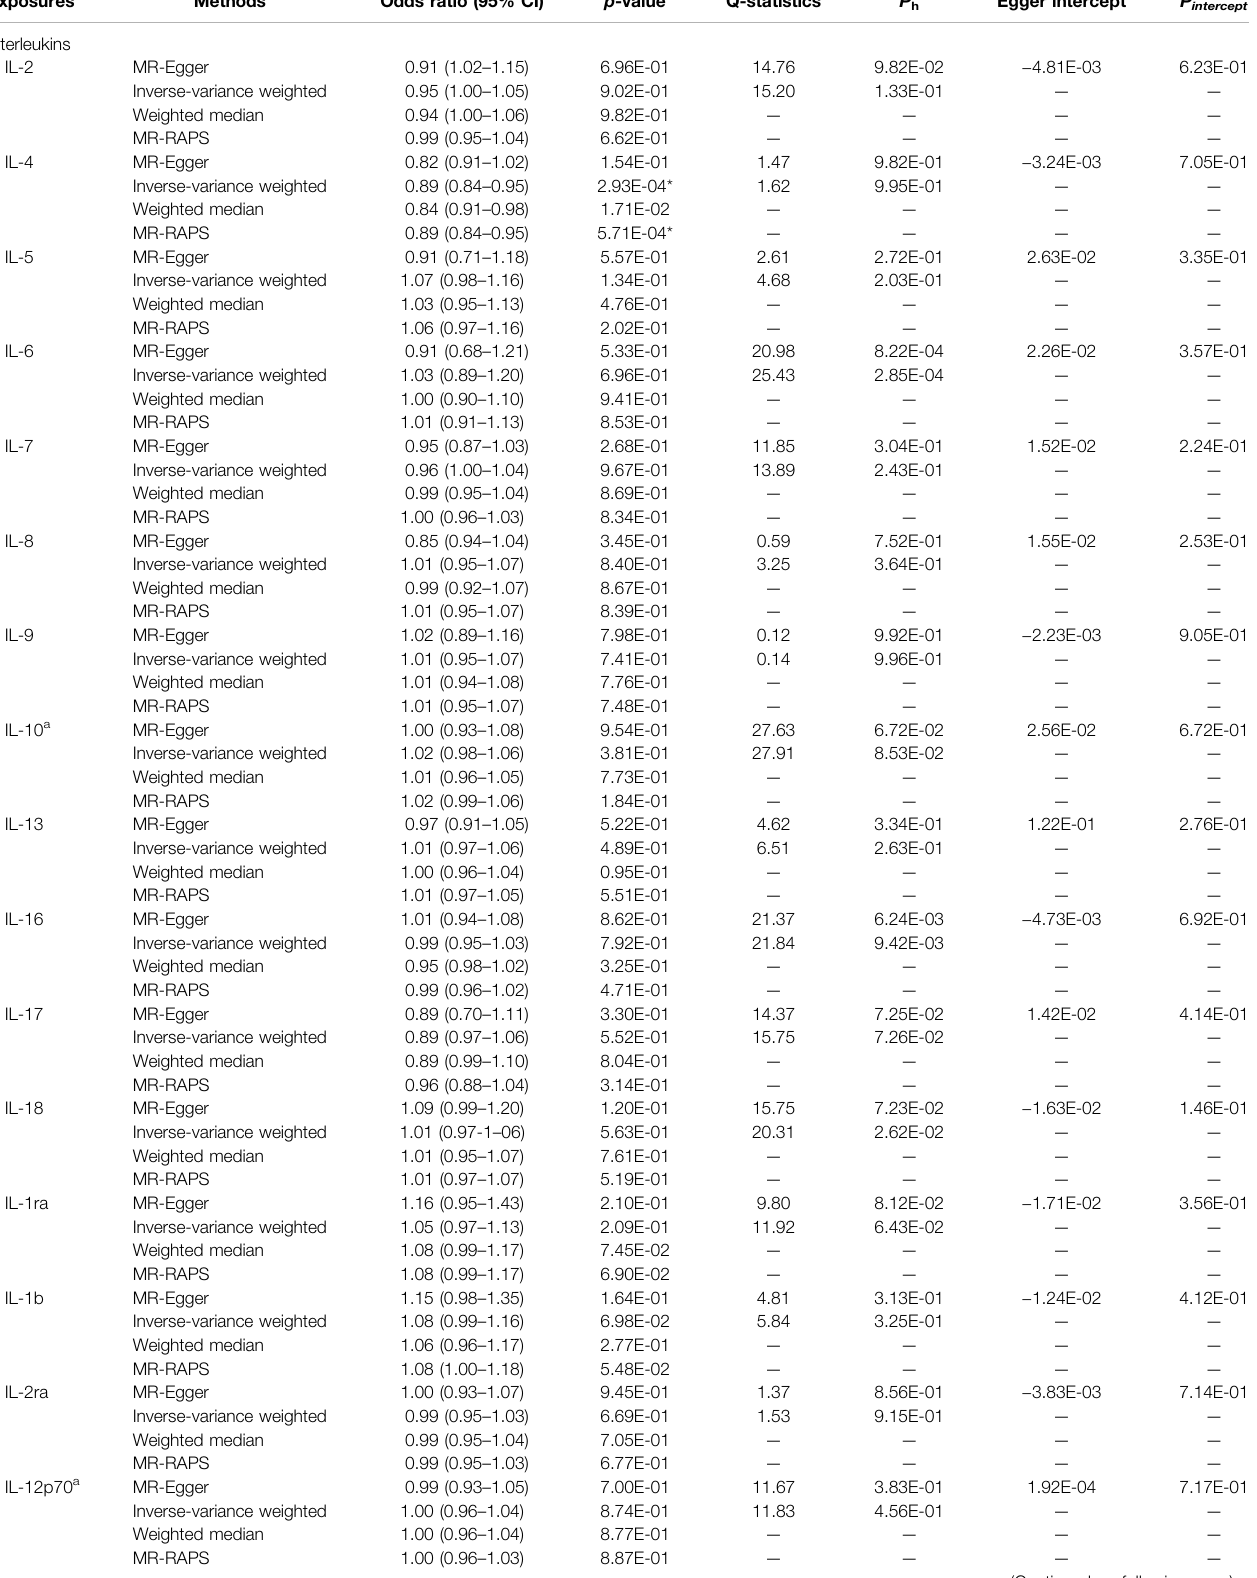
TABLE 2 | Two-sample MR estimations showing the effects of interleukins, chemokines, and other cytokines on the ischemic stroke.